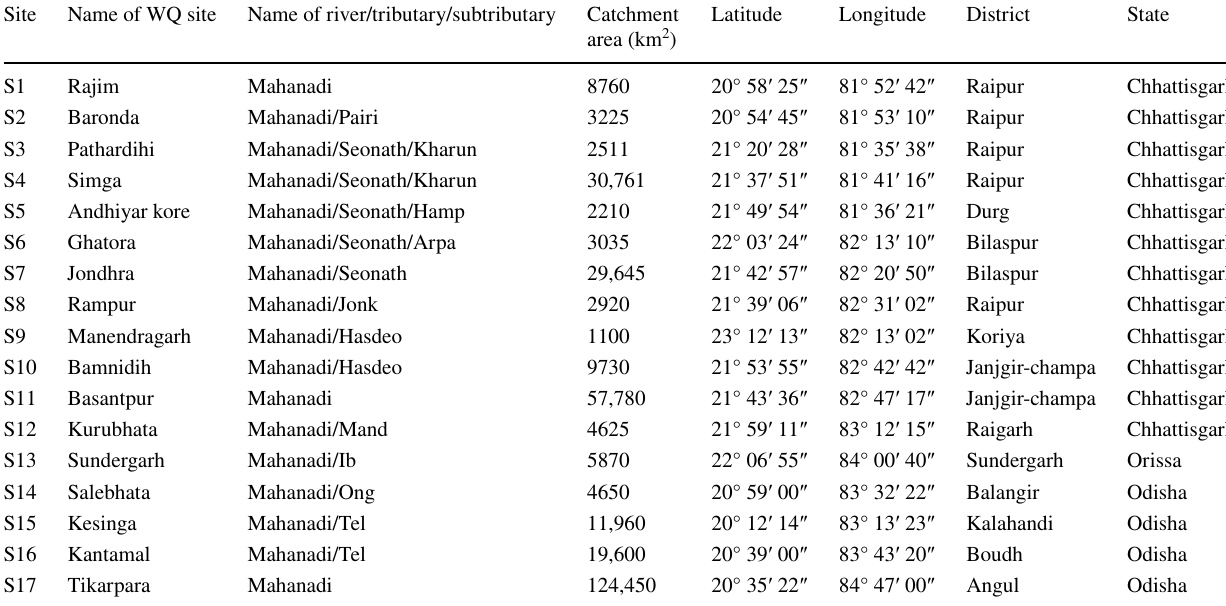
Table 1 Hydrological characteristics of the WQ stations across Mahanadi River Site Name of WQ